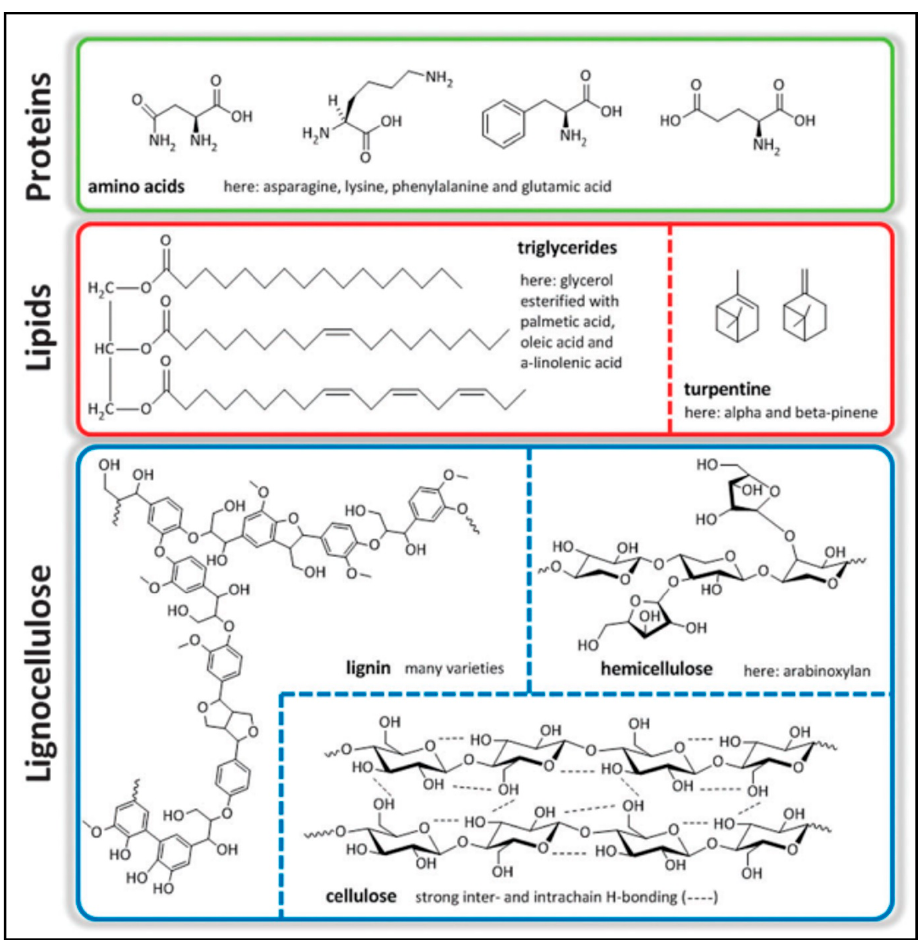
Figure 1. Illustrates the essential components of biomass feedstock [10] (Open